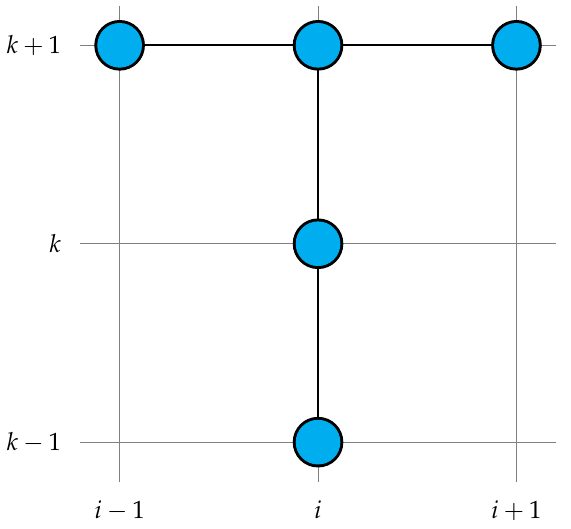
Figure 3. The stencil of the implicit scheme used in this